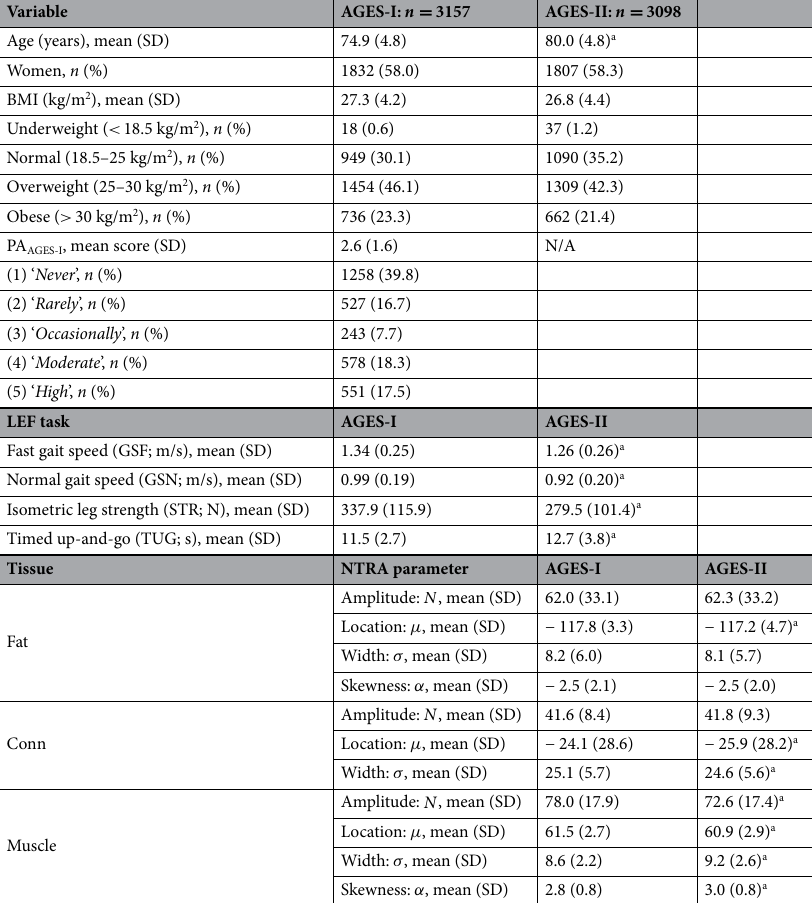
Table 1. AGES-I and AGES-II covariate statistics, LEF tasks, and NTRA parameters. a Significant difference ( P < 0.05) between AGES-I and AGES-II.